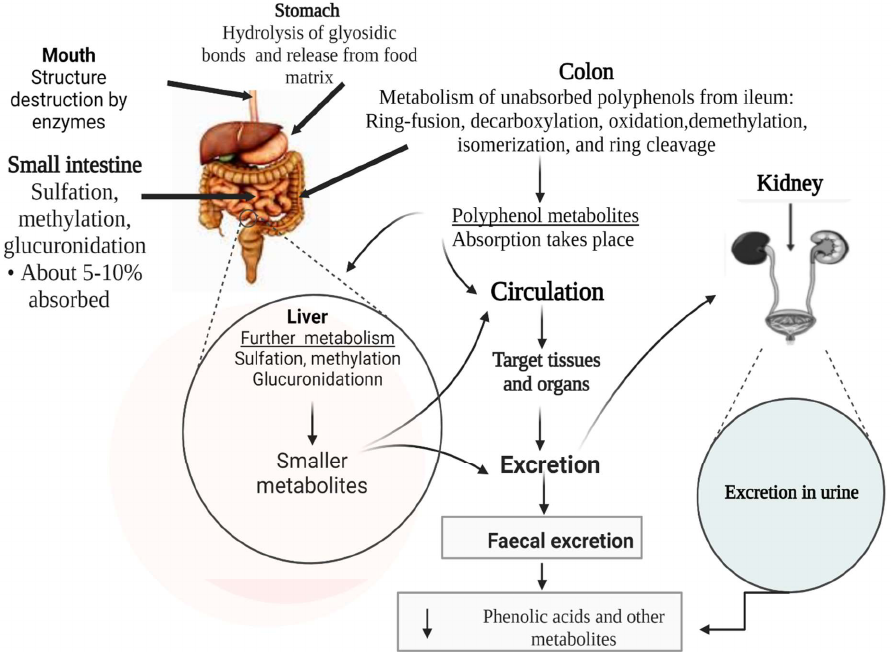
Figure 5. Metabolism fate of polyphenols by the human gut microbiota. In the mouth, the structure of polyphenols is broken down by enzymes, releasing the compounds from the food matrix. In the stomach, the polymeric polyphenols and their glycosidic bonds are hydrolyzed as the digestion process continues. Once they reach the small intestine, polyphenols undergo enzymatic deglycosylation, and absorption of some digested compounds (5–10%) takes place. The absorbed phenolic compounds enter the circulation and reach the liver, where they are metabolized further into smaller metabolites. At the same time, in the large intestine, gut microbiota hydrolyses unabsorbed polyphenols, making them available for absorption into the blood stream. Eventually, polyphenols metabolites are released from the body either through fecal matter or urine excretion.